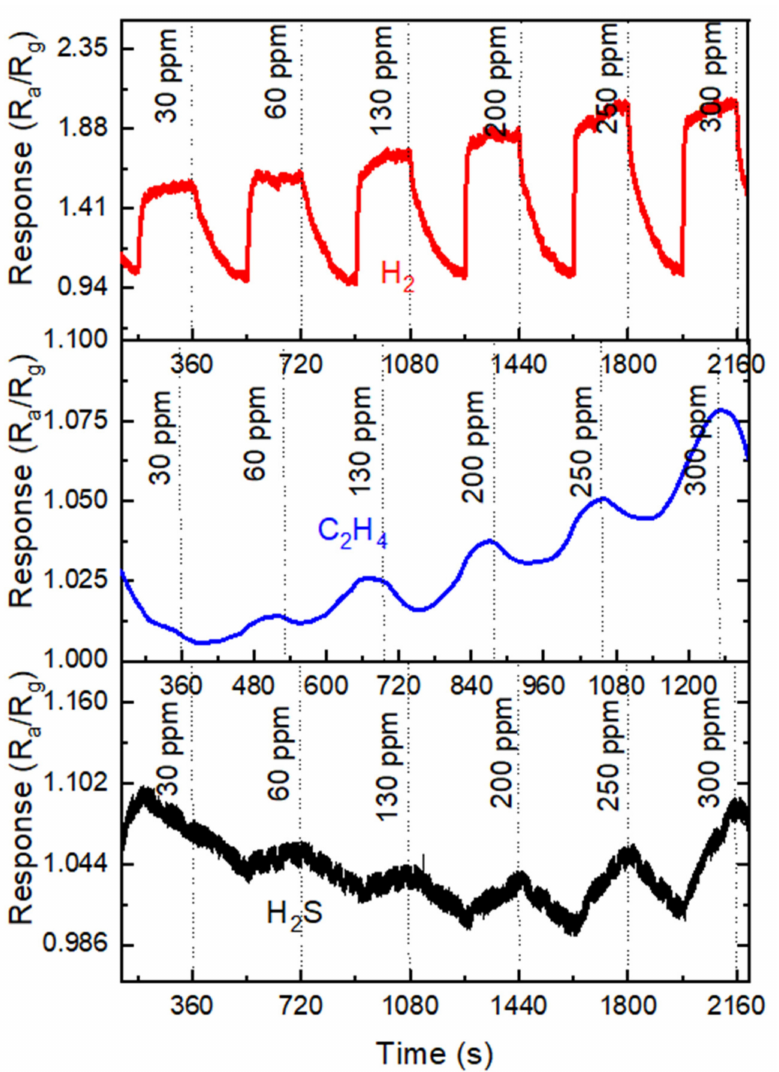
Figure 14. Sensor responses for H 2 , C 2 H 4 , and H 2 S gases at 23 ◦ C. Reproduced from [139], with permission Copyright Elsevier,